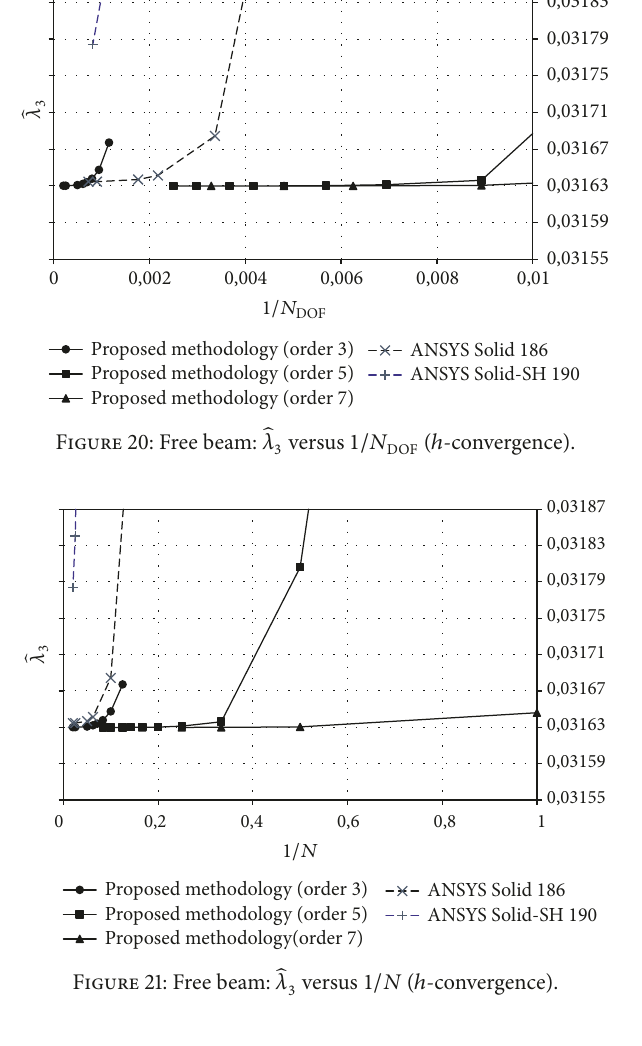
Figure 23: Free beam: